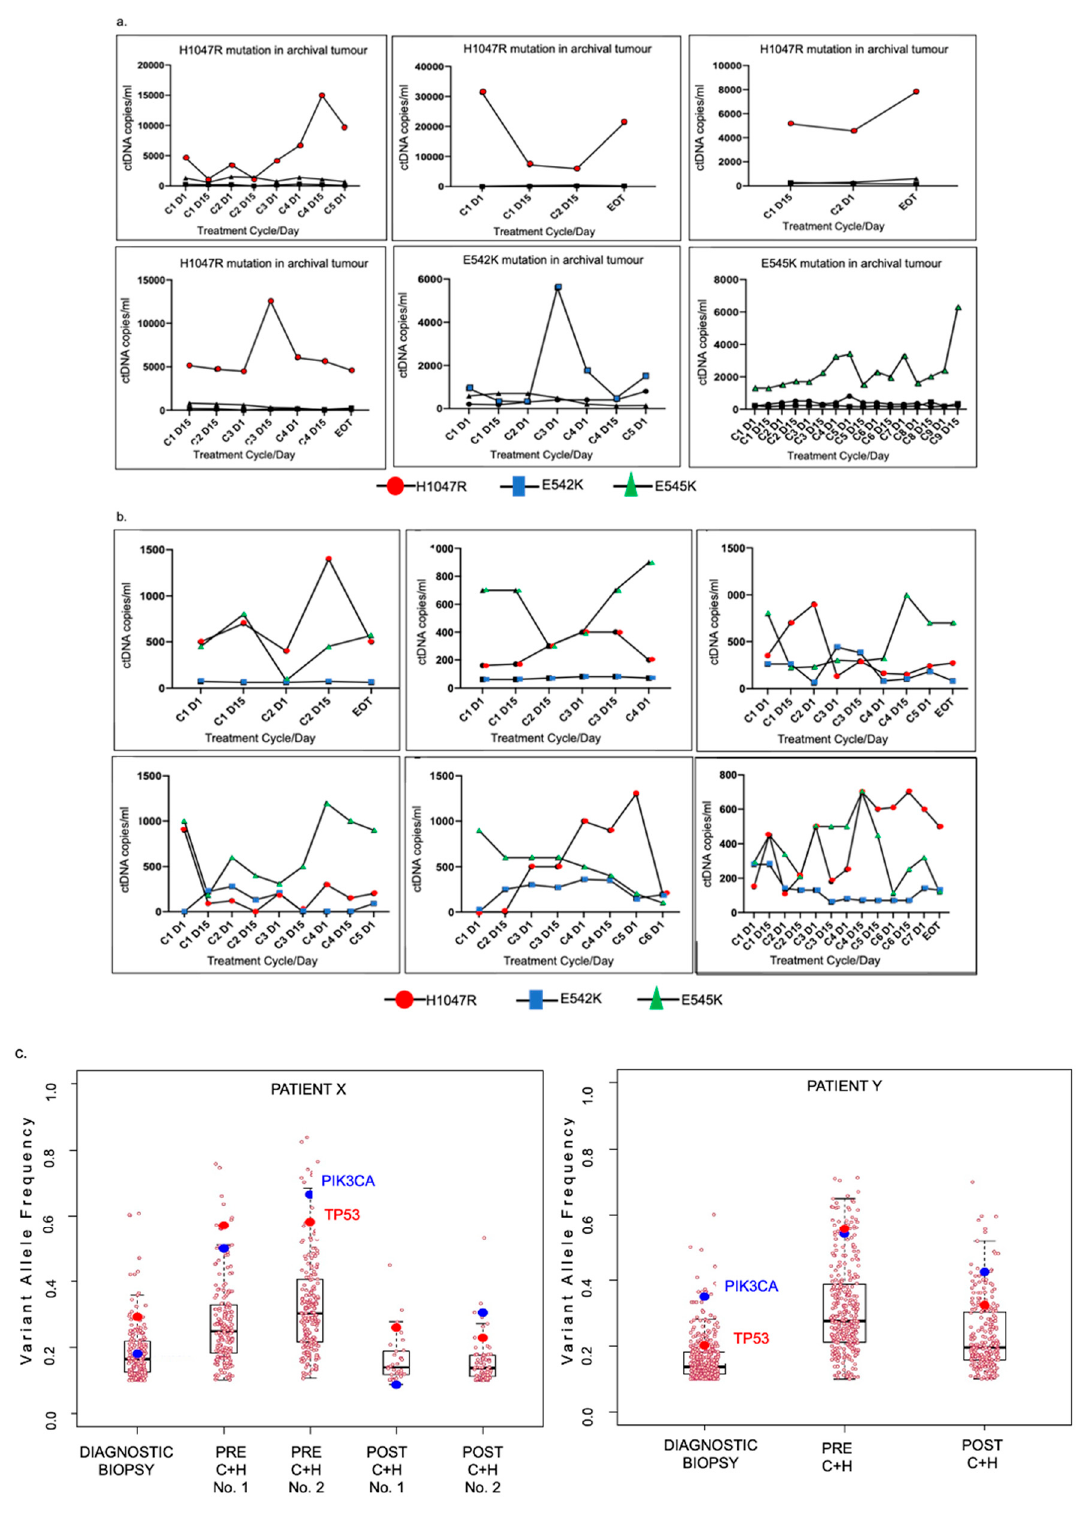
Figure 2. ( a ) Serial circulating PIK3CA mutant alleles (ctDNA) in patients with PIK3CA mutation in archival tumour (n = 6); ( b ) Serial Circulating PIK3CA mutant alleles (ctDNA) in patients with no PIK3CA mutation in archival tumour (n = 6); ( c ) changes in the variant allele frequency in serial tumour samples.